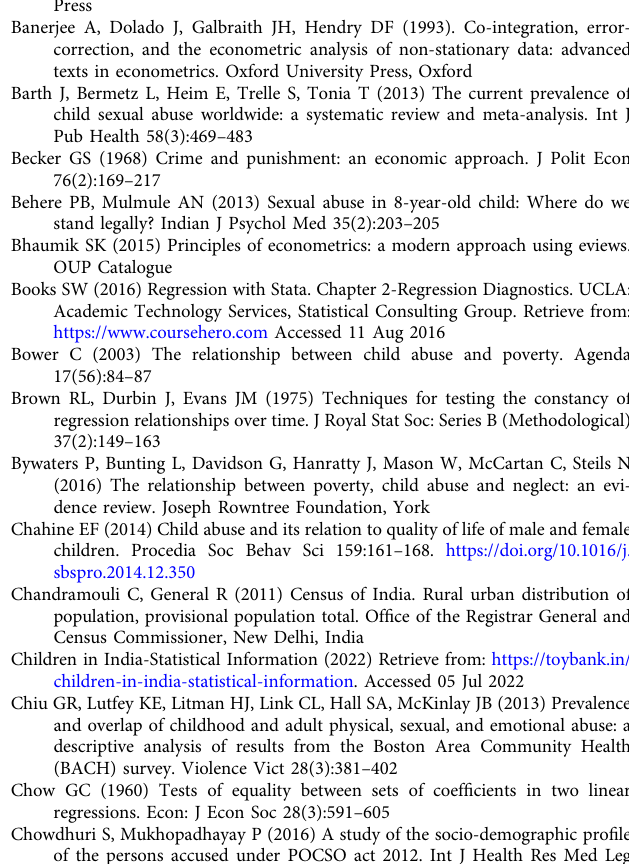
Table 11 Descriptive statistics of the regression variables. Variables Mean Std. dev. Minimum